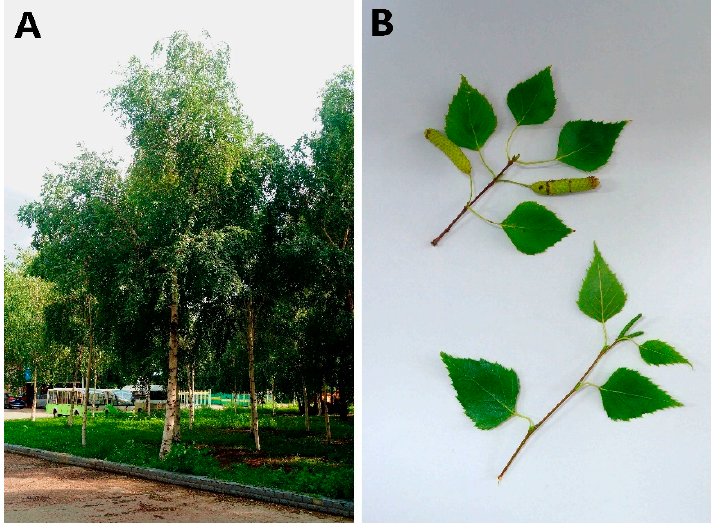
Figure 1. Adult tree ( A ), leaves and inflorescences ( B ) of Betula platyphylla on the Northeast Forestry University campus (45°43 ′ 21 ″ N, 126°38 ′ 30 ″ E).